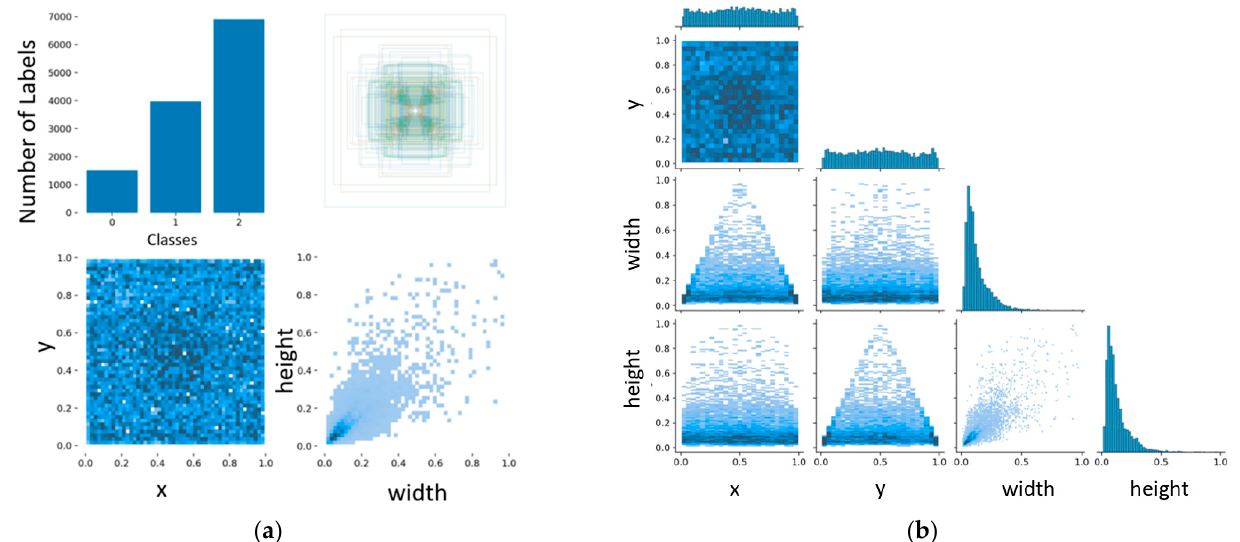
Figure 7. Correlogram of the classes ( a ) Label distribution ( b ) Label Correlation.